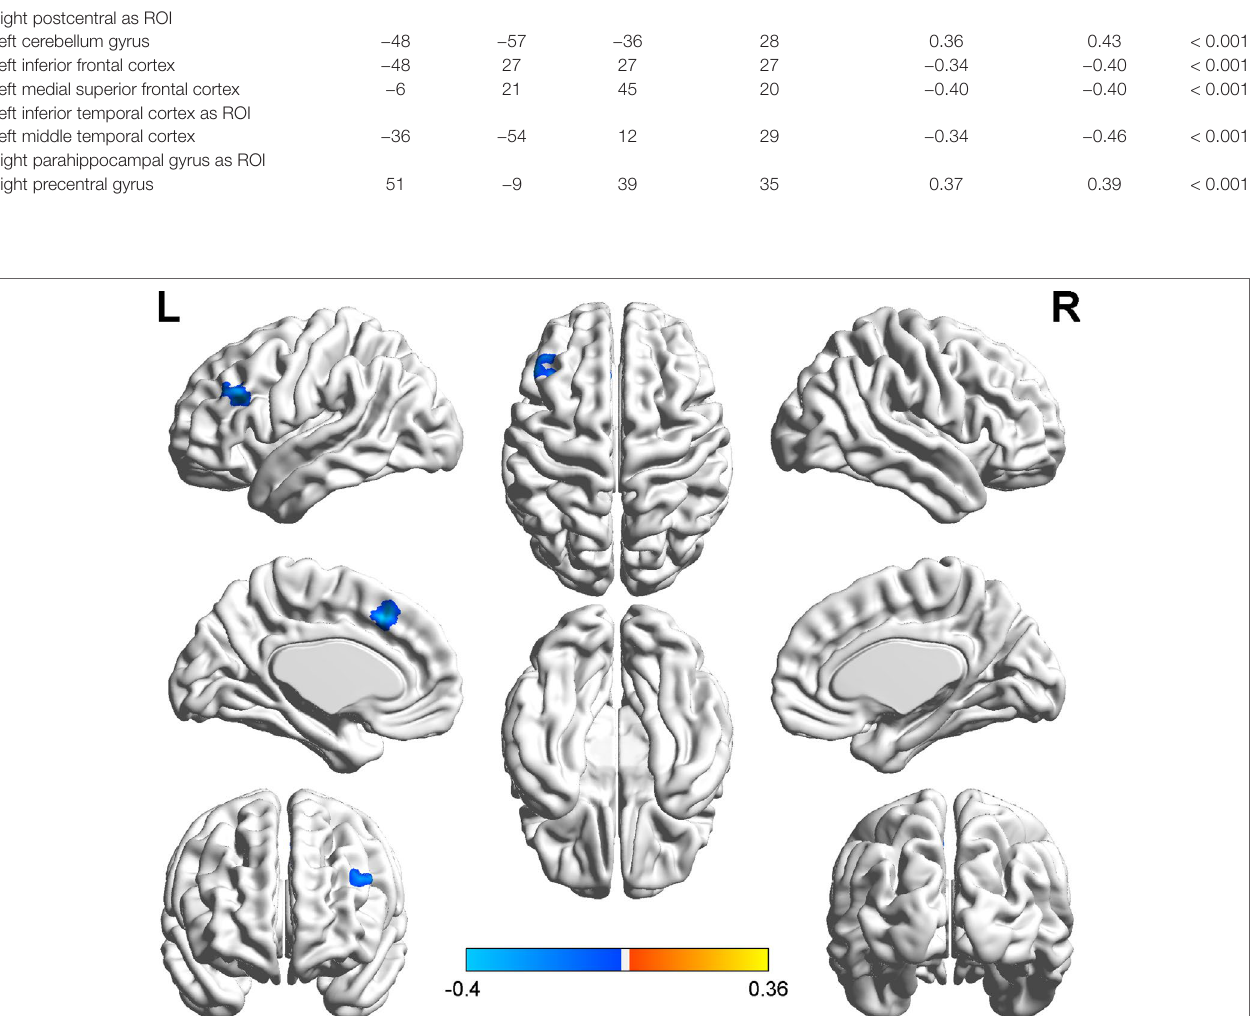
FIGURE 4 | Brain regions with significant correlations between functional connectivity (FC) and state anxiety.